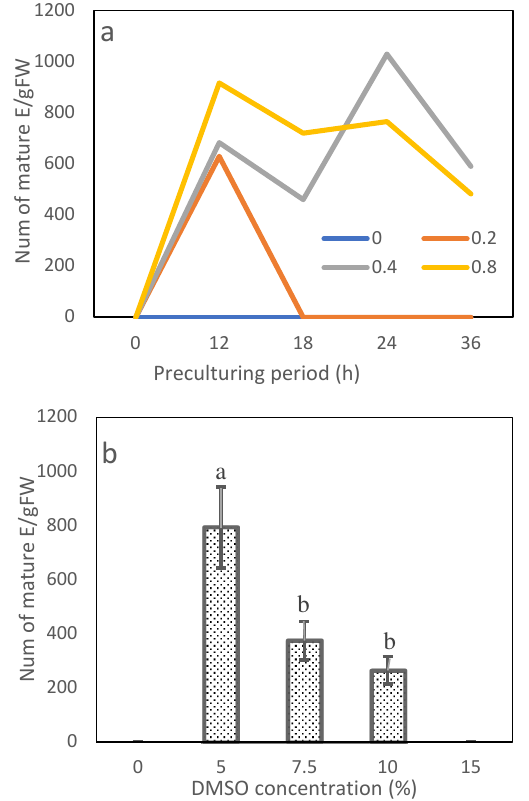
Figure 7. Maturation efficiency from cryopreserved embryo tissues by experiment: ( a ) combination of sorbitol concentration and preculture period and ( b ) DMSO. Values with the same letters marked on ( b ) were insignificant.